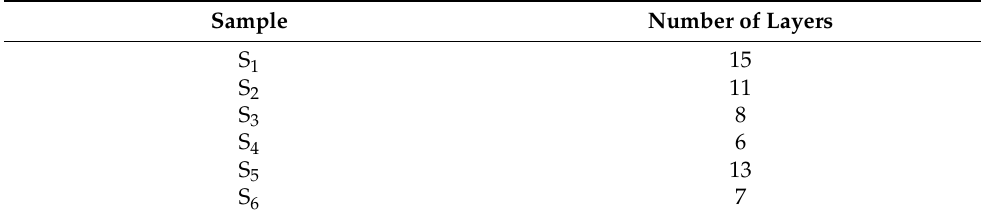
Table 4. Distribution of layers of copper mesh in the sliding plate.